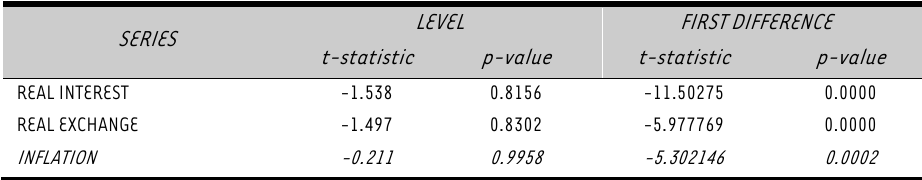
Results of the Augmented Dickey Fuller unit root